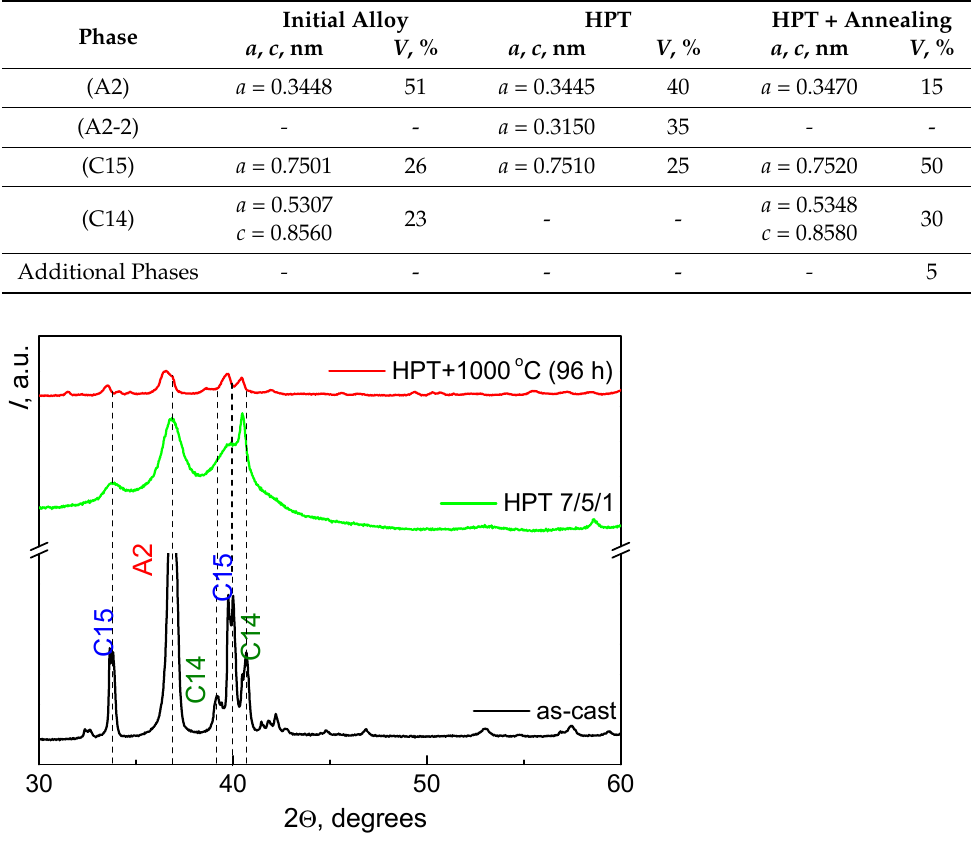
Figure 8. Diffraction patterns for the TiZrHfMoCrCo alloy in the as-cast state (black line) after HPT (green line) and after HPT plus annealing at 1000 °C 96 h (red line).